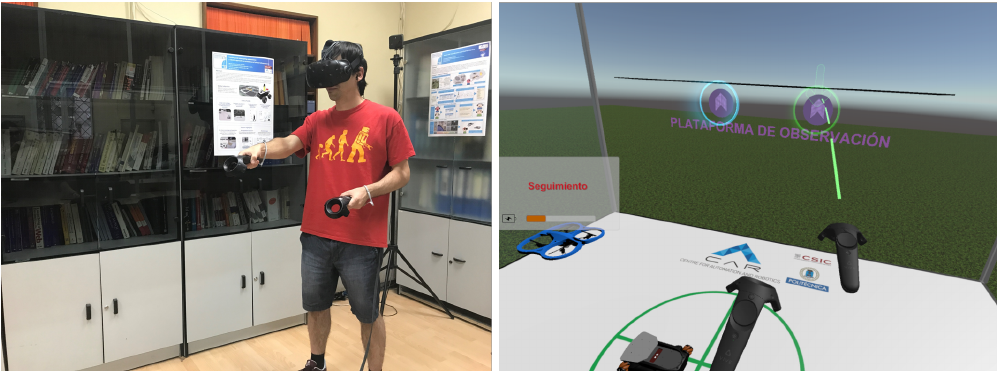
Figure 12. Testing virtual reality interfaces. ( left ) An operator working hard in real world. ( right ) What the operator is doing in virtual